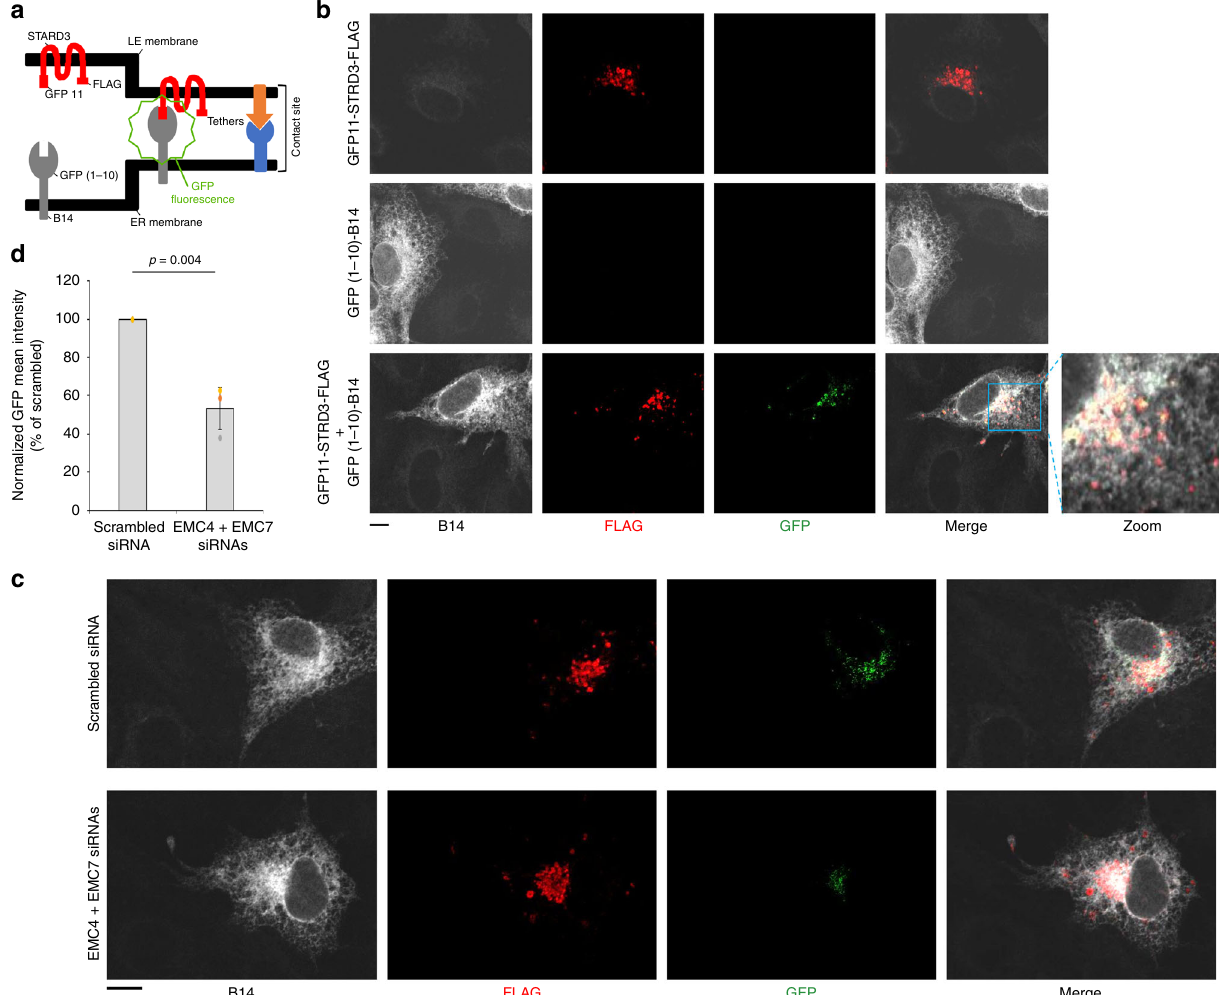
Fig. 6 EMC4 and EMC7 mediate ER-LE contact. a Graphical representation of the split-GFP assay for detecting ER-LE contacts. b CV-1 cells transfected with the indicated construct(s) were fi xed, stained with B14 and FLAG antibody, and analyzed under confocal microscope for GFP signal. This experiment was independently repeated three times. Scale bar = 10 µ m. c CV-1 cells co-expressing GFP11-STARD3-FLAG and GFP (1-10)-B14 and transfected with either scrambled or EMC4 + EMC7 siRNAs were fi xed, stained with B14 and FLAG antibody, and analyzed under confocal microscope for GFP signal. Scale bar = 10 µ m. d Mean GFP signal intensity from c was normalized with FLAG signal and quanti fi ed by FIJI/ImageJ. The image analysis was done on a single z-plane. Values represent means ± SD from three independent experiments. Unpaired Student two-tailed t -test was used to determine statistical signi fi cance. Source data are provided as a Source Data